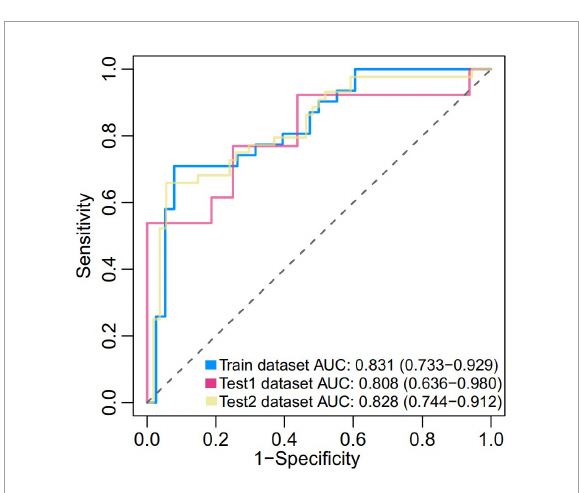
FIGURE5 Receiver operator characteristic (ROC) of the prediction model based on a set of six different texture features (f2, f3, f4, f5, f10, and f11) of great significance extracted from diffusion weighted imaging (DWI) in both the train (0.831, [0.733, 0.929]), test1 (0.808, [0.636, 0.980]), and test2 dataset (0.828, [0.744,